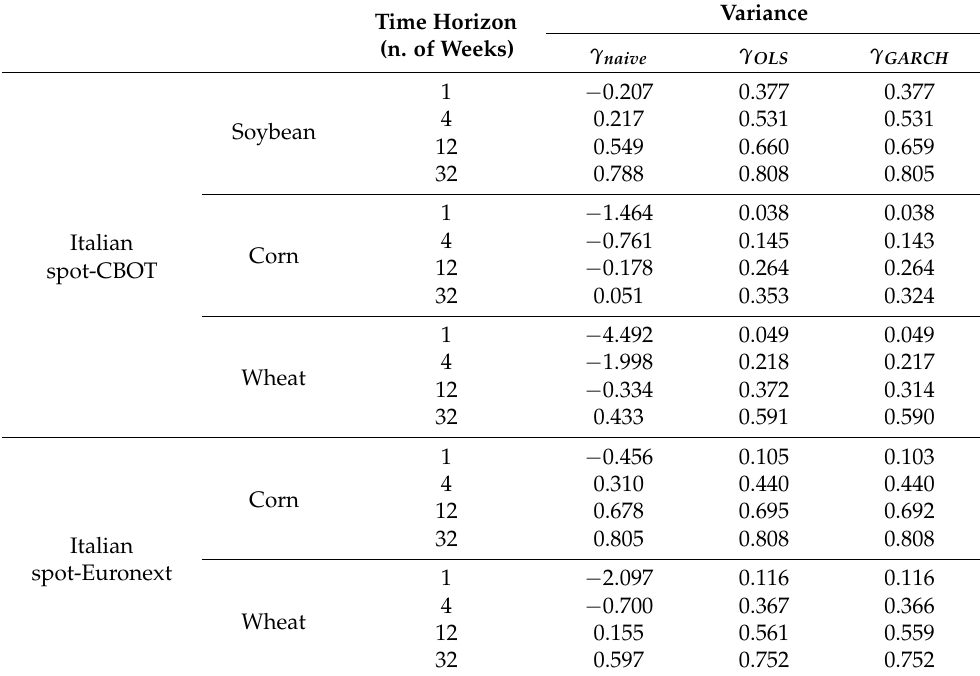
Table 3. Estimates of the Hedging Effectiveness through variance reduction, for all the considered commodities.